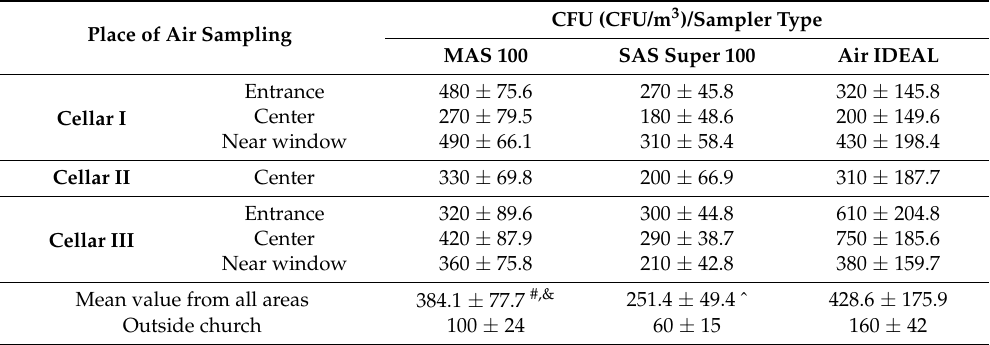
Table 2. CFU collected air samples in the studied areas, depending on the sampler type. Place of Air